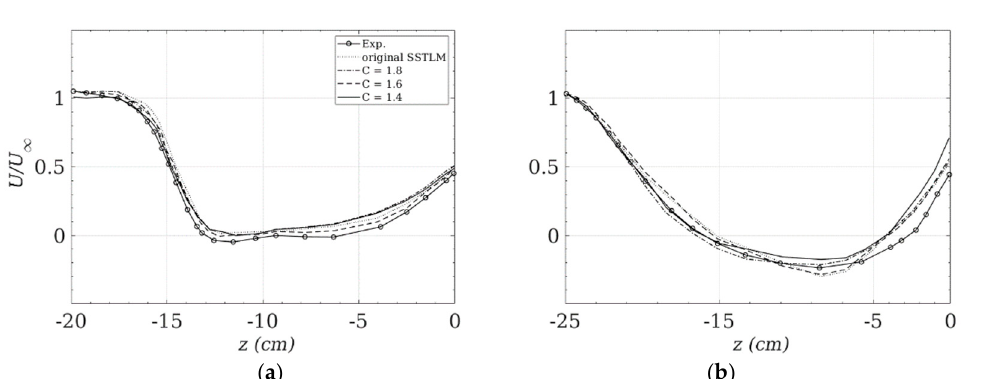
Figure 2. Tuned SSTLM model, Re θ = Re Ω / C , compared with experimental measurements in the wake of ( a ) the upper arm and ( b ) the thigh of the extended leg. The measurement for the arm is at y = 1.1 m, and for the thigh is at y = 0.95 m, and x/d = 0.8 downstream of the cross-section center. d is the width of the cross-section.